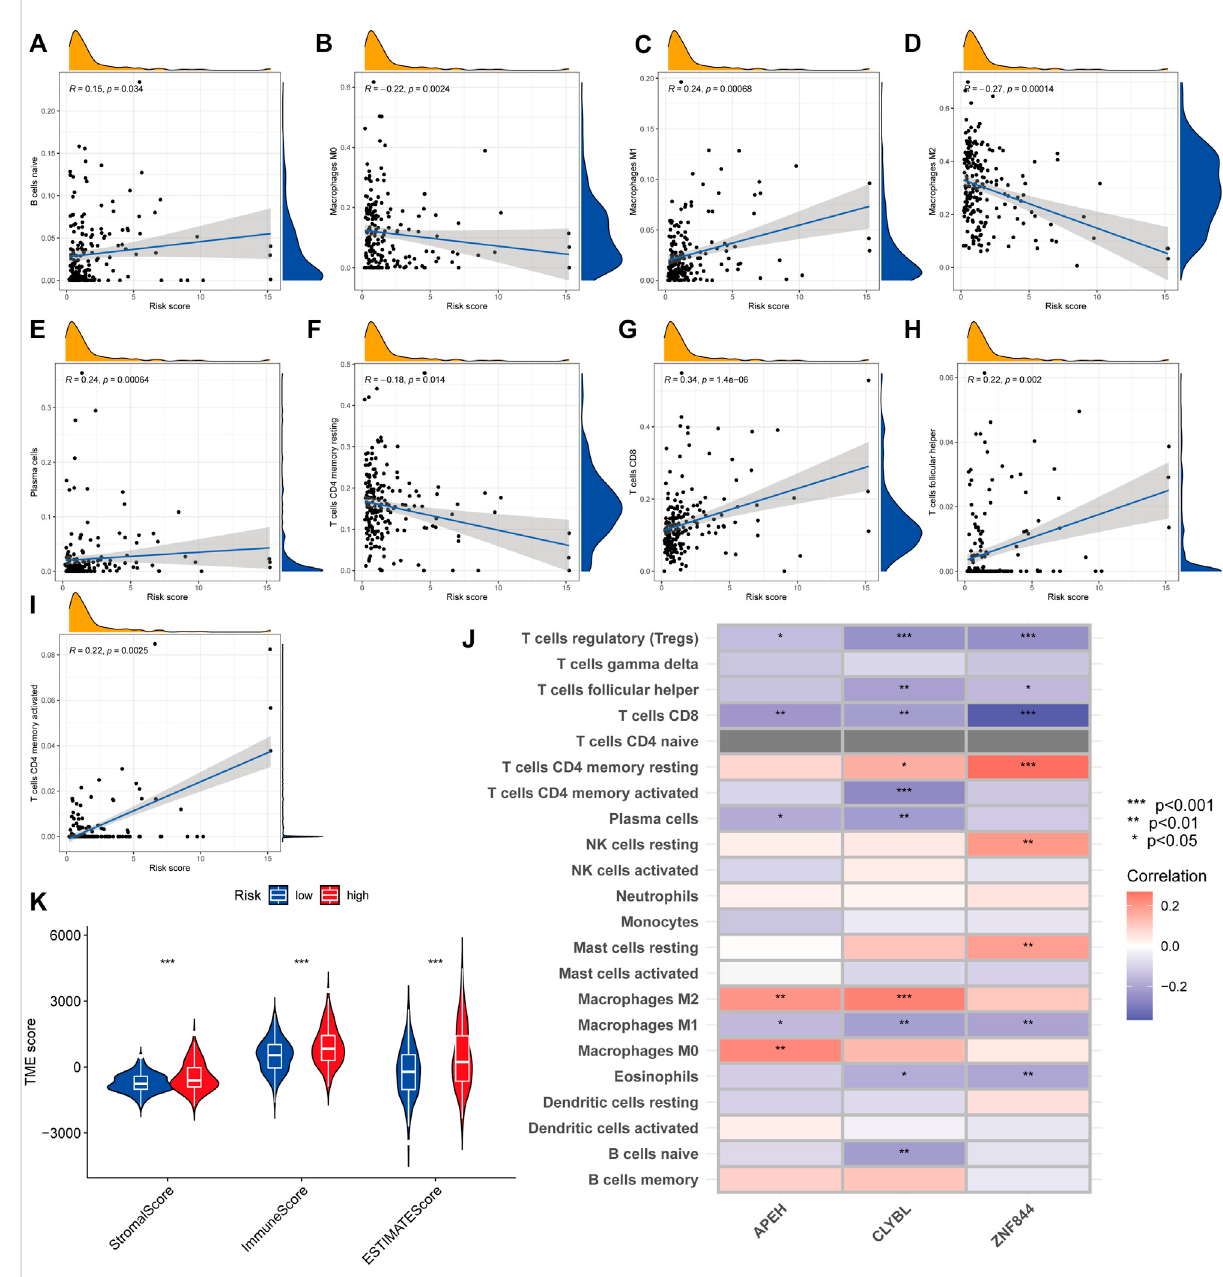
FIGURE 8 Comparative analysis of tumor microenvironment in various risk categories. (A – I) Relationship between the risk score and the kind of immune cells. R represents the correlation coef fi cient, and when it is positive, it means that immune cell in fi ltration is positively correlated with the risk score, and vice versa . (J) Relationship between immune cell abundance and three genes included in the suggested model. Red represents a positive correlation between immune cell in fi ltration and gene expression, and blue represents a negative correlation. The darker the color, the greater the correlation. (K) Relationship between risk score and both immune and stromal scores. A greater risk score was shown to be substantially associated with a higher immunological score, stromal score, and ESTIMATE